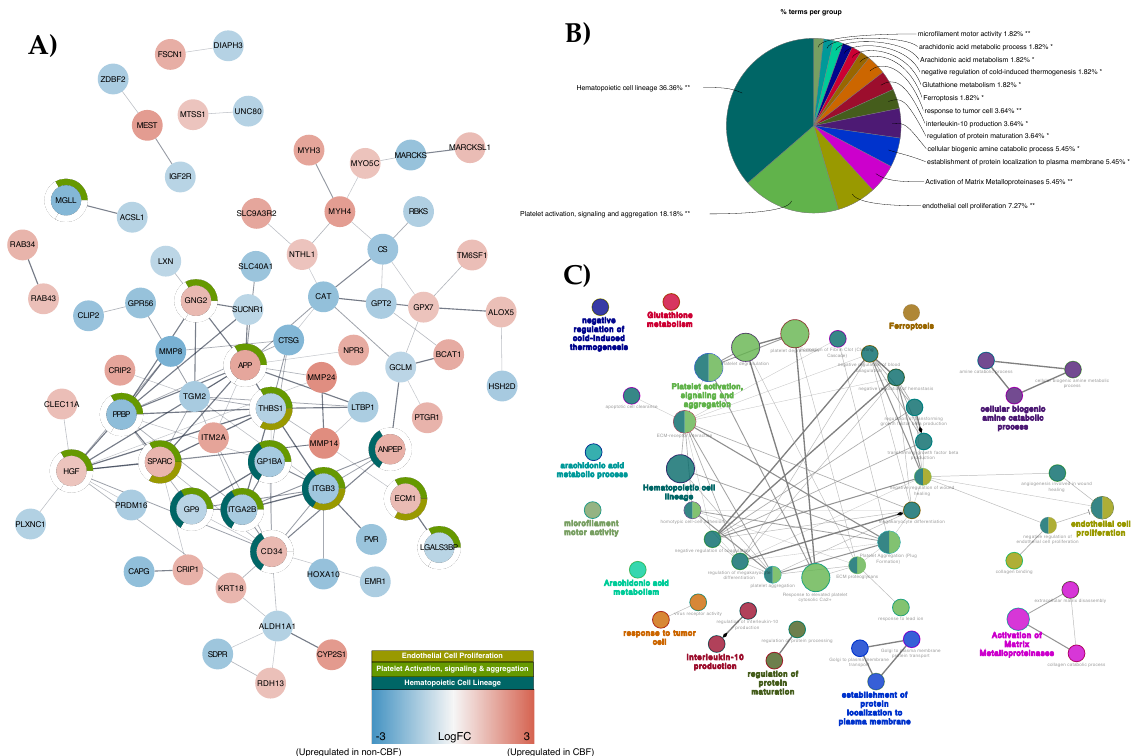
Figure 2. Interaction and functional analysis of 117 significant DEPs present in CBF and non-CBF AML comparison: ( A ) STRING protein–protein interaction (PPI) network of significant DEPs. Nodes represent proteins, and edges connecting nodes represent interaction. The PPI network has been simplified by concealing singletons. Red positive Log2FC nodes are upregulated proteins in CBF AML, while blue negative Log2FC nodes are upregulated proteins in non-CBF AML; ( B ) Functional grouped network enrichment by ClueGO with percent terms per group, and the most significant enriched grouped terms is hematopoietic cell lineage (* or ** indicate significant terms at the p < 0.05 and p < 0.01 statistical levels, respectively); ( C ) Functional grouped terms are nodes showing only terms with most significance (FDR < 0.05), and nodes are linked base on their kappa score level (>0.4). The node size represents the number of terms enrichment significant, and functionally related groups partially